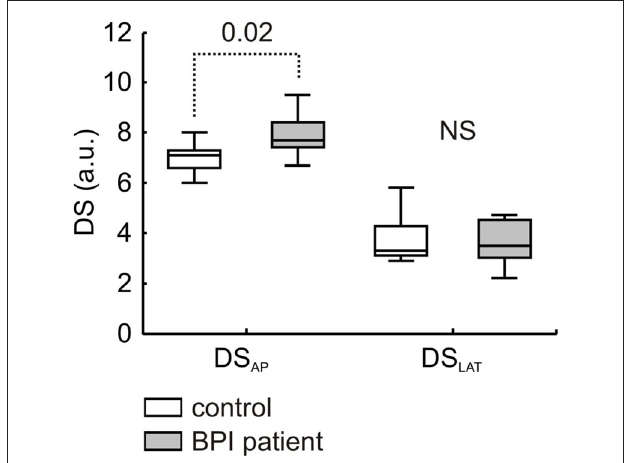
FIGURE 1 | COP directional stability values in anterior-posterior (DS AP ) and lateral (DS LAT ) directions. Median, lower-upper quartiles and min-max values are represented. Data were presented for control (white bars) and patients with brachial plexus injury (gray bars) groups ( n = 11 for each group). Dotted line refers to significant difference, and number inset refers to Mann-Whitney p -value. NS indicates no significant difference ( p =